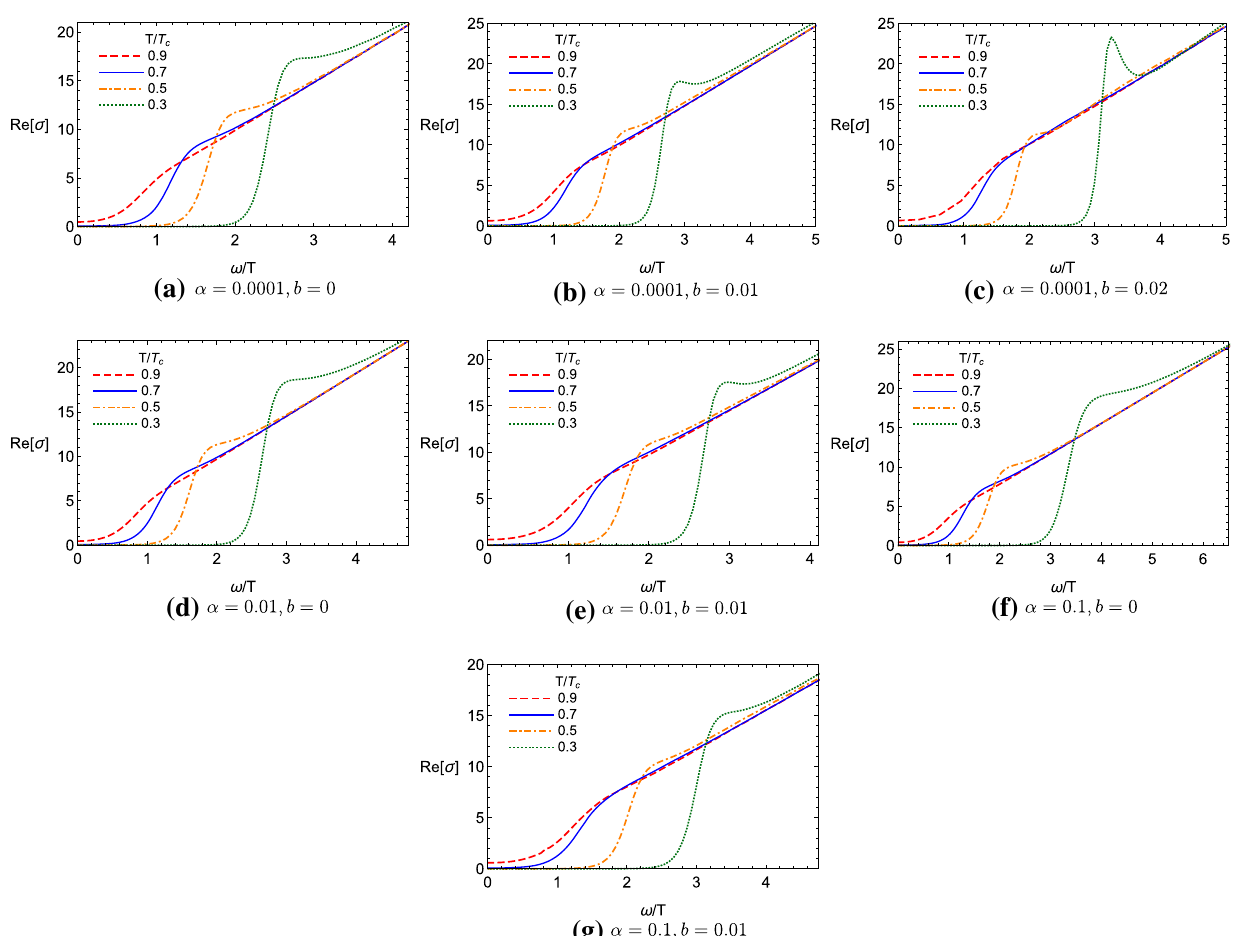
Fig. 4 The real part of the conductivity as a function of frequency for different values of b and α . Each figure is plotted for different temperatures T /